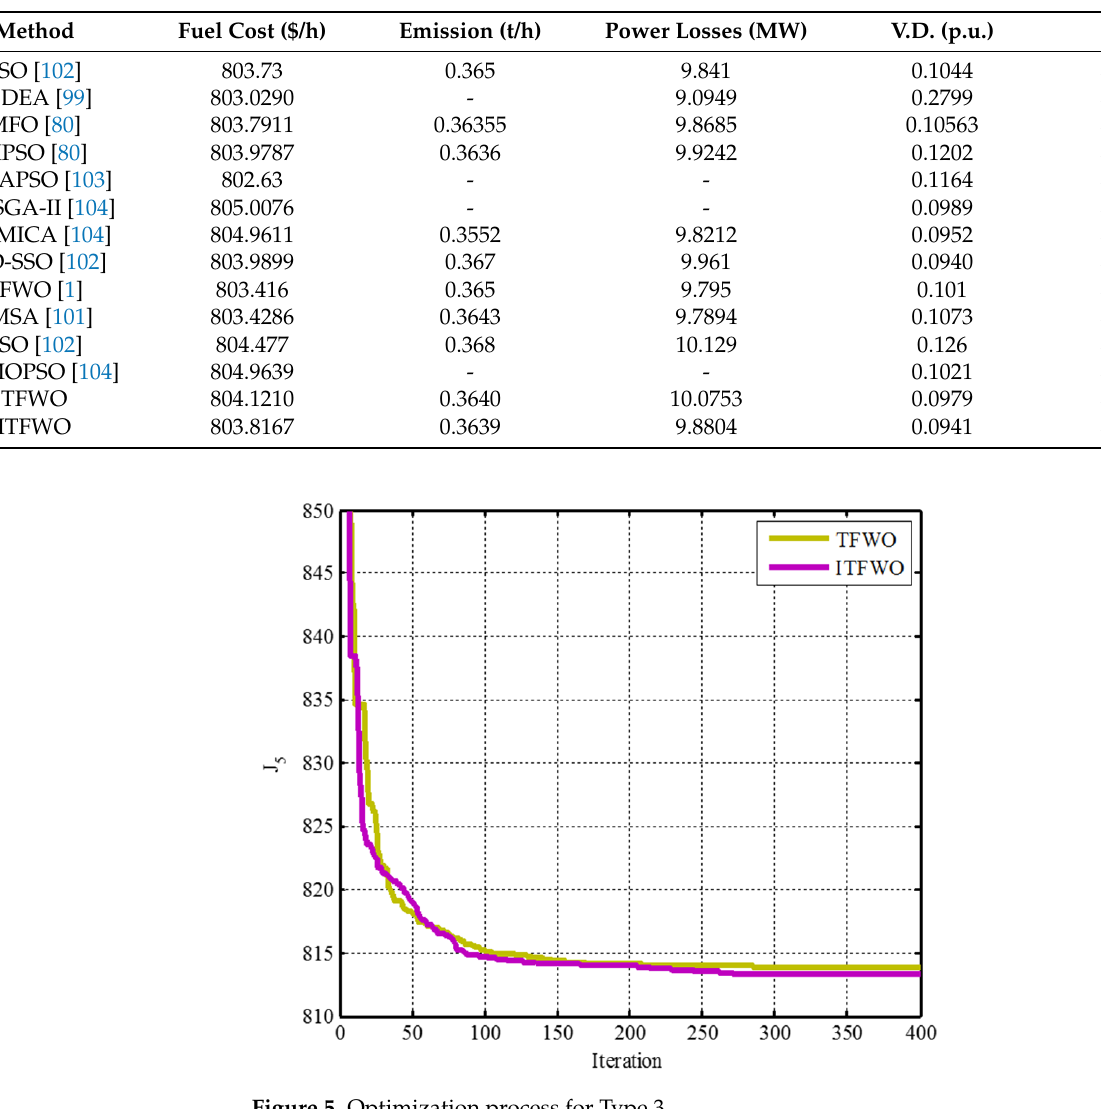
Table 4. The optimization results for Type 3.